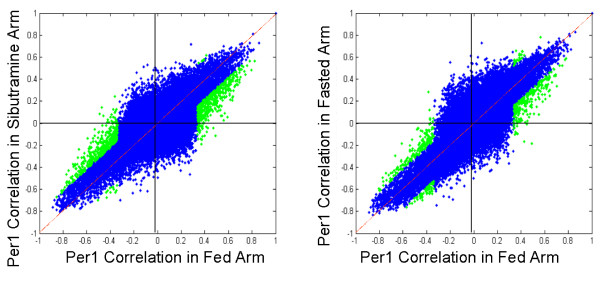
The majority of the genes in the three states, fed, fasted and sibutramine-treated, were similarly affected by the diurnal signal. Correlations to PER1 in the three states were very high (blue dots), indicating that the diurnal effect overwhelmed the rest of the perturbations. However, a small number of genes had correlations to PER1 that were significantly different between the states (green dots). The correlation plots are slightly tilted off the diagonal.